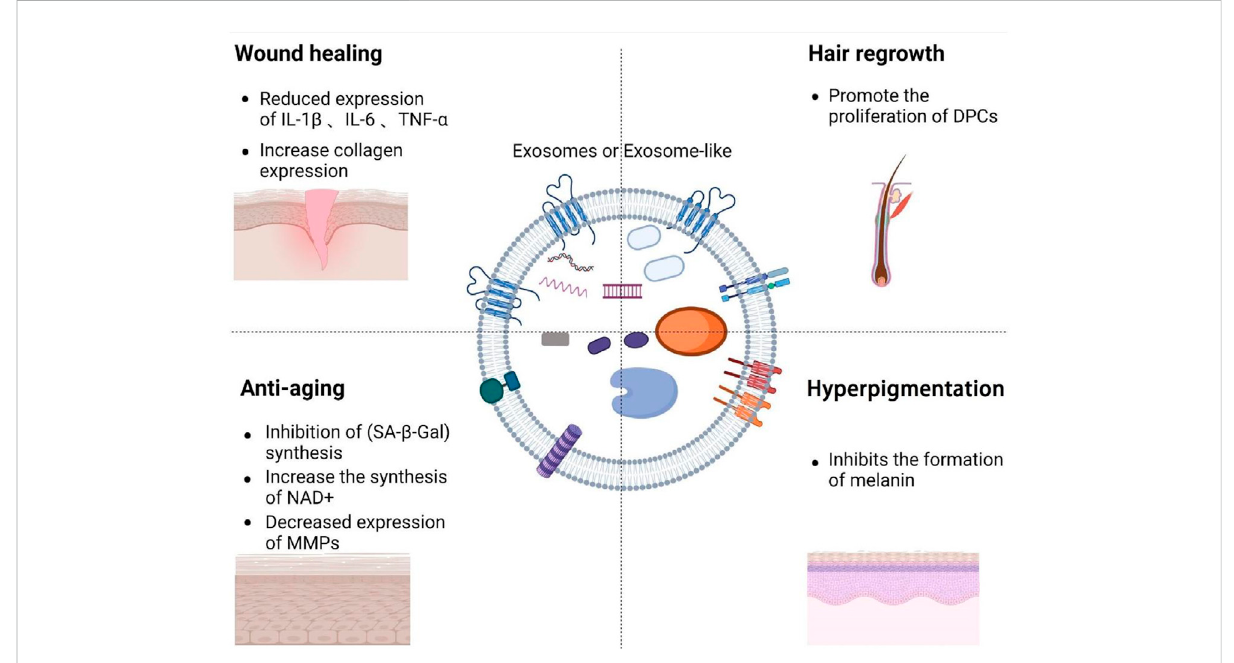
FIGURE 1 Overview of the composition of exosomes and the role of exosomes in medical